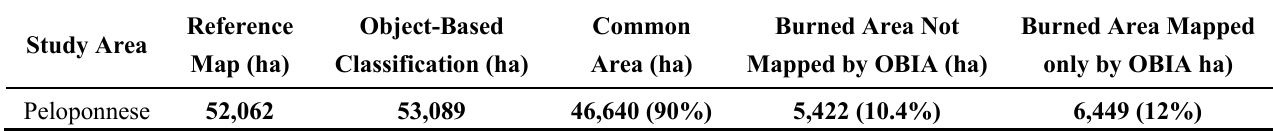
Table 3. Sizes of the burned areas and results of the spatial overlays between the reference map and the object-based classification result for the study area of the